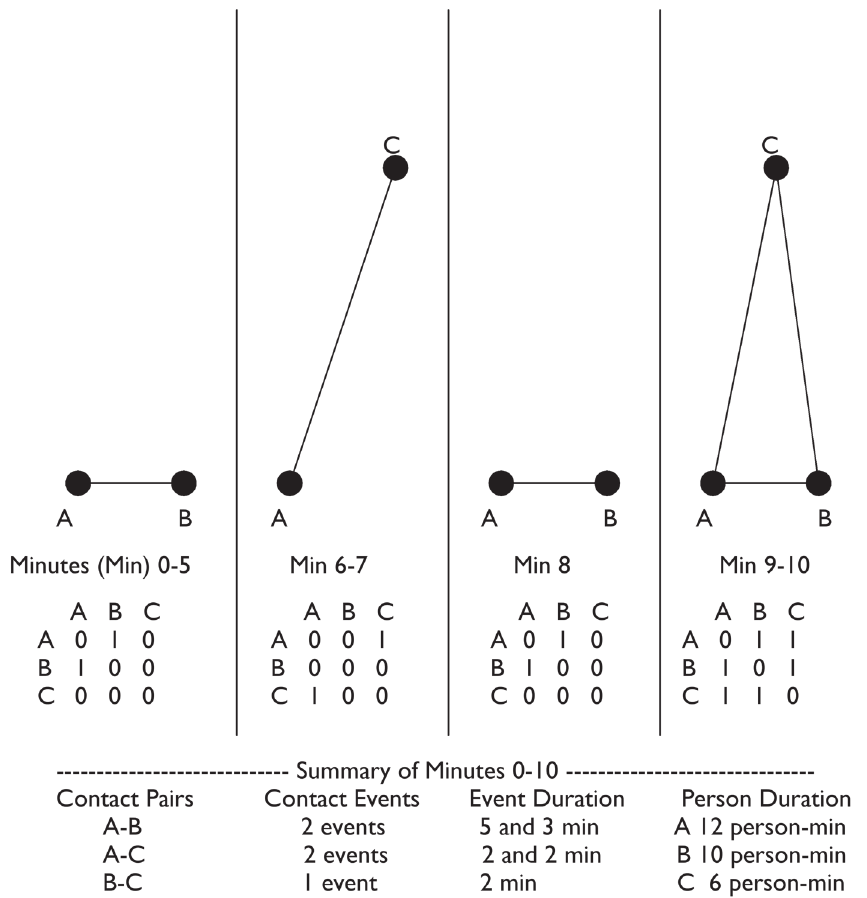
Figure 2. A schematic representation of contact, event, and duration. The schematic above demonstrates how three individuals (A, B, and C) come into contact with each other over a 10-minute period.